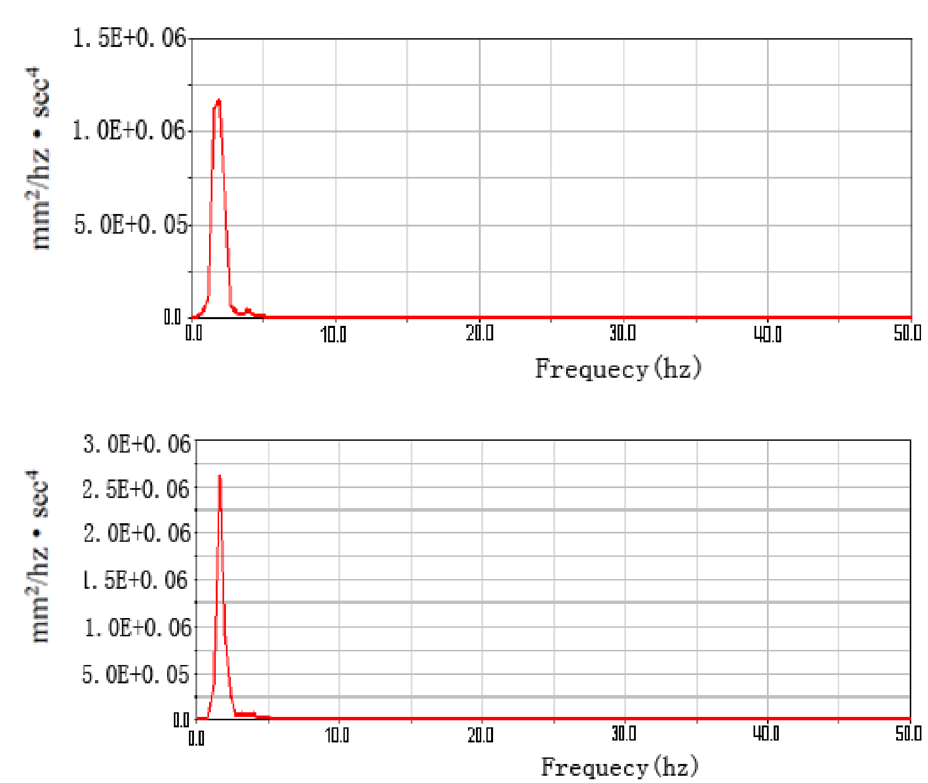
Fig. 11 Test 6. Acceleration Response Curve